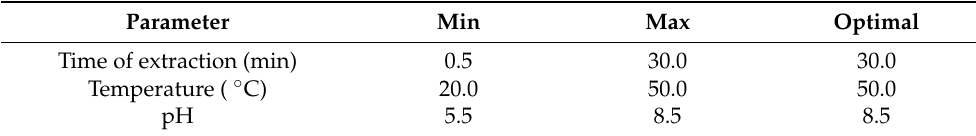
Table 5. Time of extraction, temperature and pH ranges and optimal values obtained after the optimization of the response surface model.